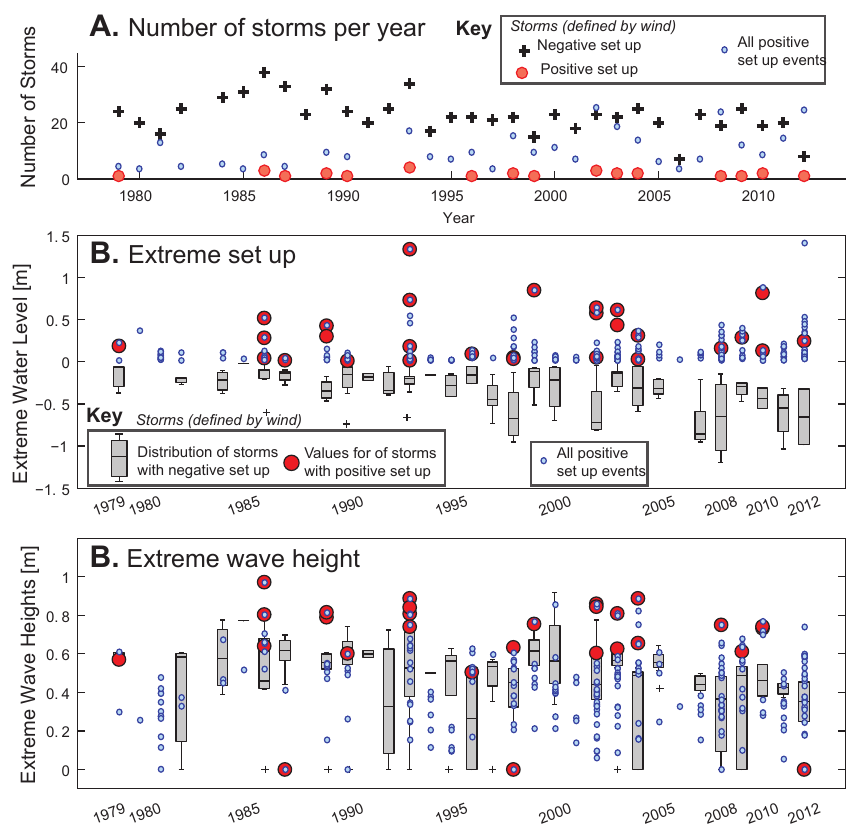
Figure 14. Number of storms per year (a) , magnitude of extreme setup or set down (b) and magnitude of extreme wave height (c) for all storms (defined as wind ≥ 10ms − 1 , red dots and gray bars; we also show “positive setup events”, blue dots). Only a small proportion of storms set water up, and the definition of storms based on wind does not capture all positive setup events. There are no clear trends in the number of storms per year, though the number of positive setup events may be increasing.